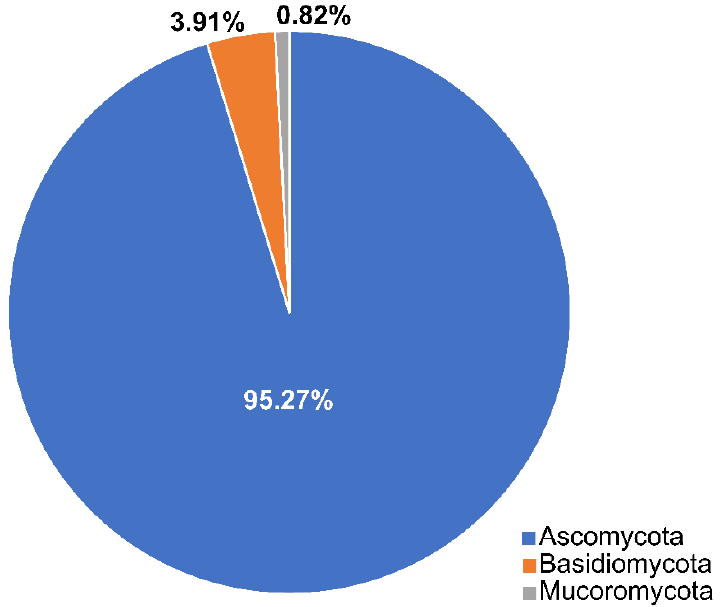
Figure 3. The distribution of salt marsh fungi among three fungal phyla.